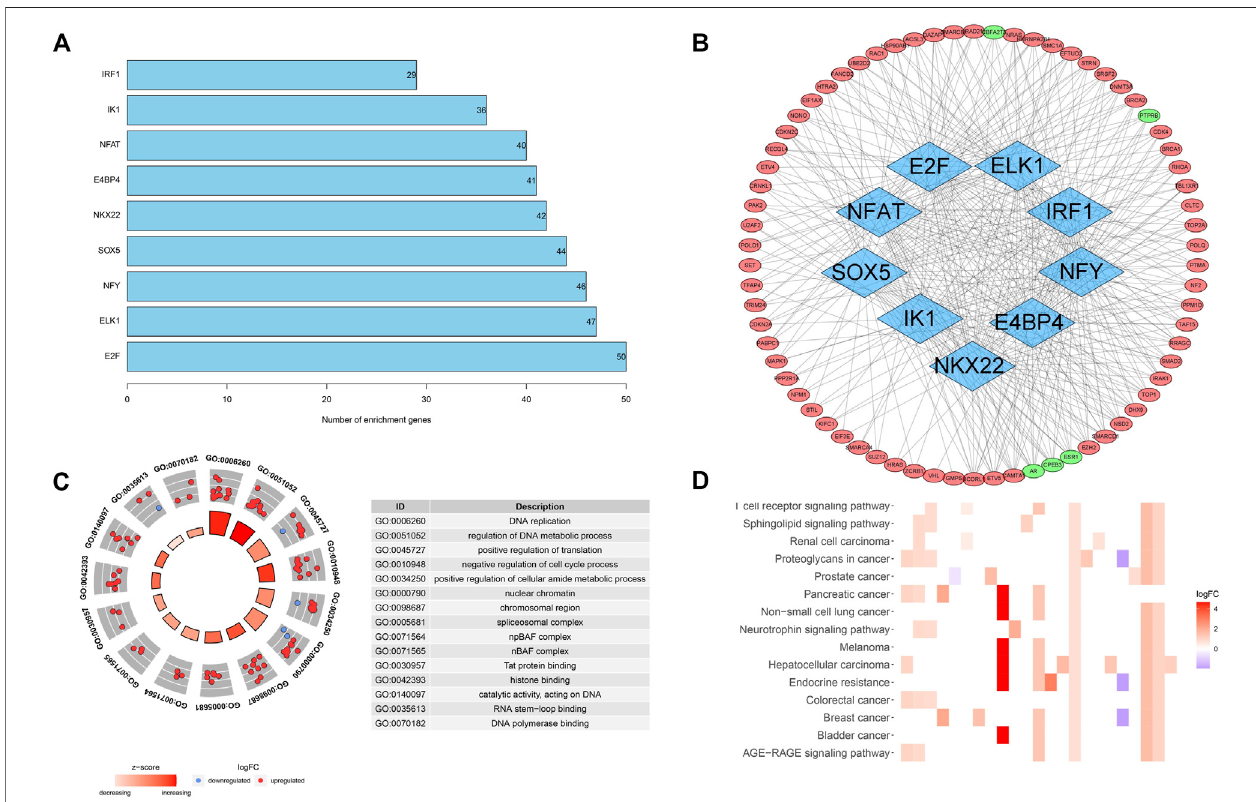
FIGURE 2 | Transcription factor regulatory networks and functional enrichment analysis. (A) The number of cancer driver genes that are highly correlated with transcription factors. (B) Regulatory networks of transcription factors and cancer driver genes. (C) GO analysis of screened cancer driver genes. (D) KEGG analysis of screened cancer driver